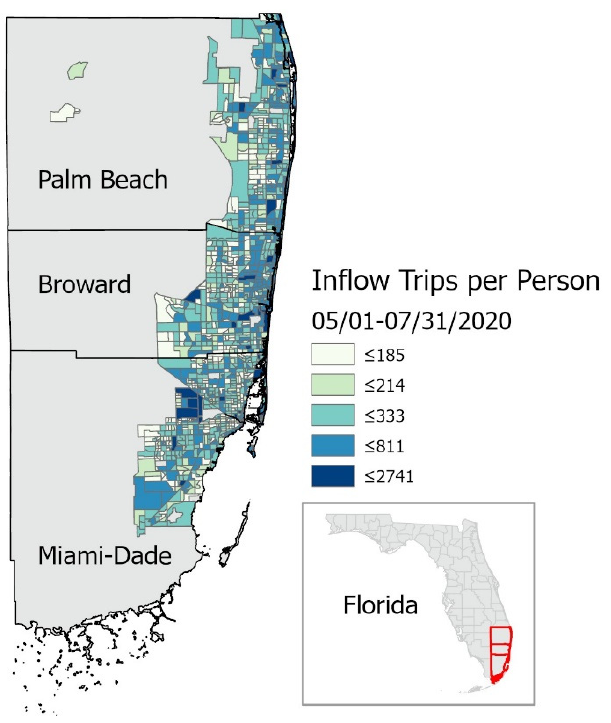
Figure 1. Inflow trips per person per census tract 05/01–07/31/2020 in Miami-Dade, Broward, and Palm Beach counties.